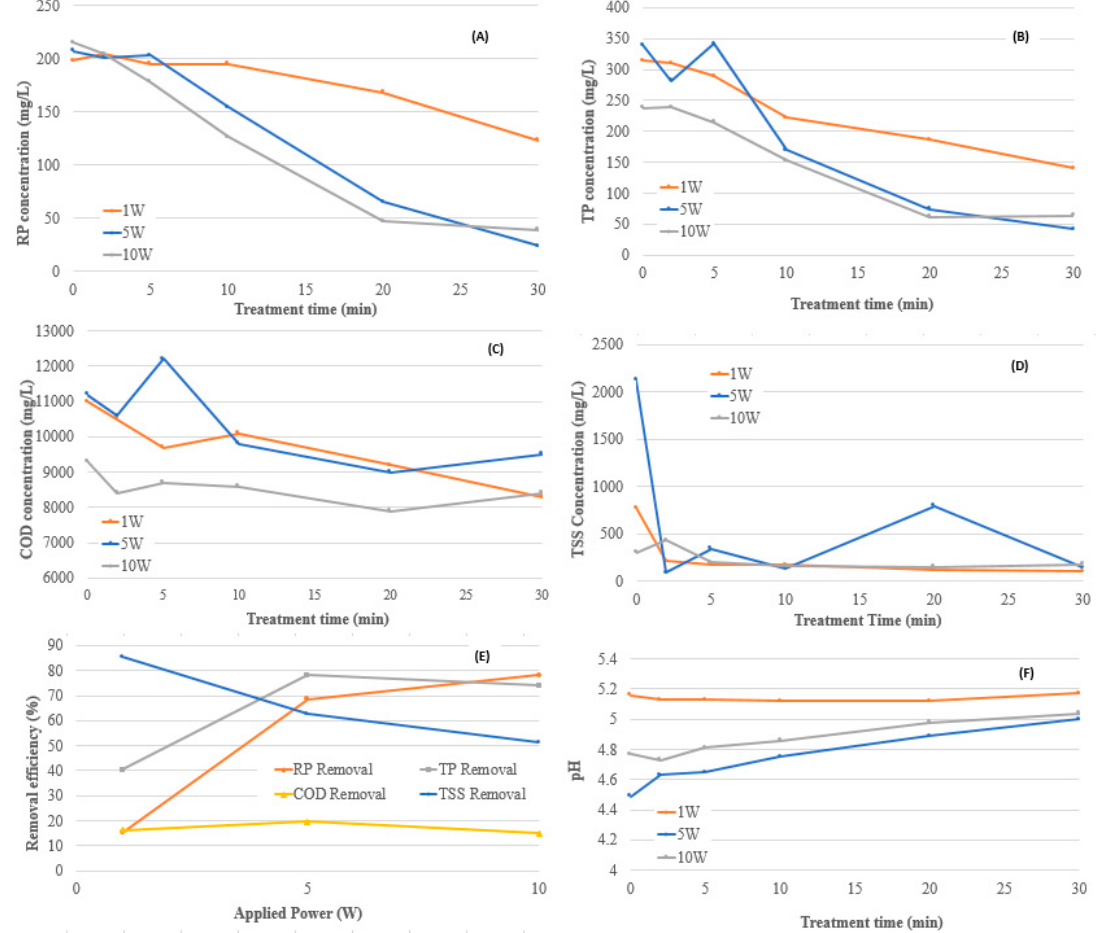
Figure 3. Effect of applied power on electrocoagulation (EC) performance. ( A ) Reactive phosphorous (RP) concentration vs. treatment time, ( B ) Total phosphorous (TP) concentration vs. treatment time, ( C ) Chemical oxygen demand (COD) concentration vs. treatment time, ( D ) Total suspended solid (TSS) concentration vs. treatment time, ( E ) removal efficiencies vs. applied power at 20-min treatment time, ( F ) pH of solution vs. treatment time.